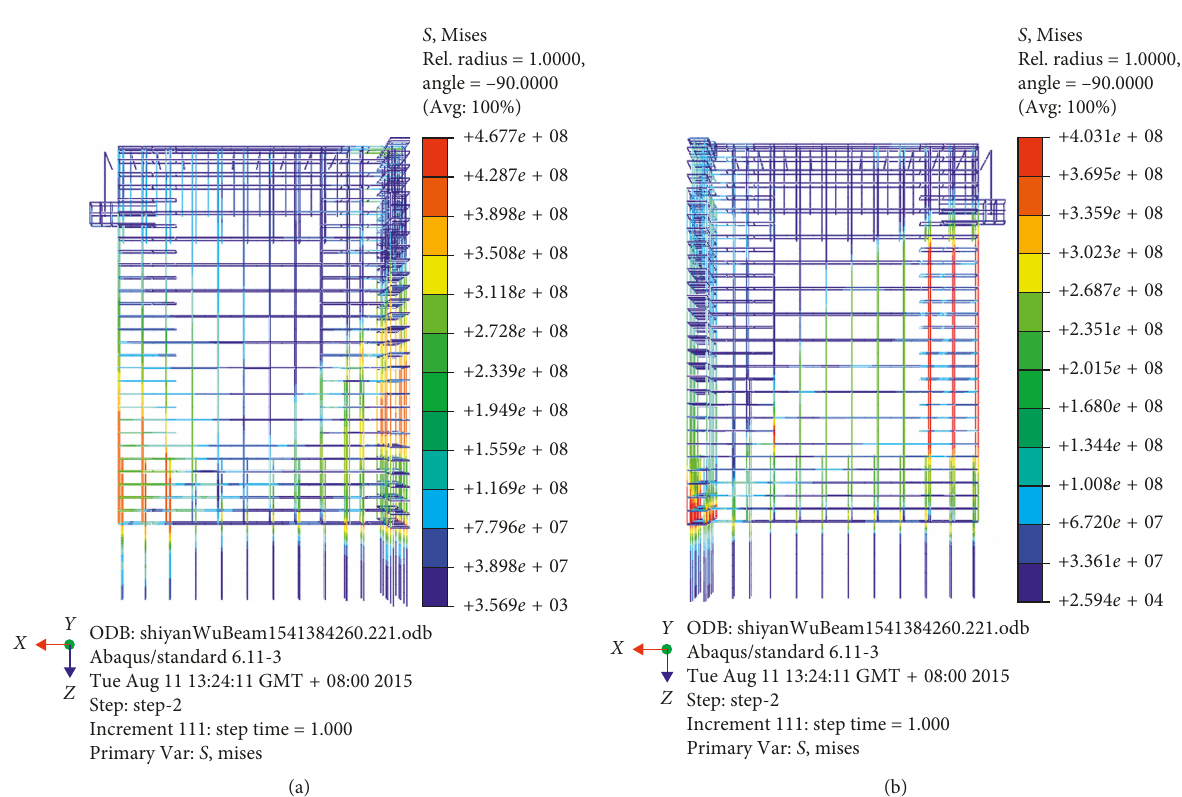
Figure 24: Steel bar stress distribution on the NPGCS finite-element spatial model. (a) Steel stress distribution on 1st floor web compressed panel of the NPGCS finite-element spatial model. (b) Steel stress distribution on 1st floor flange compressed panel of the NPGCS finite- element spatial